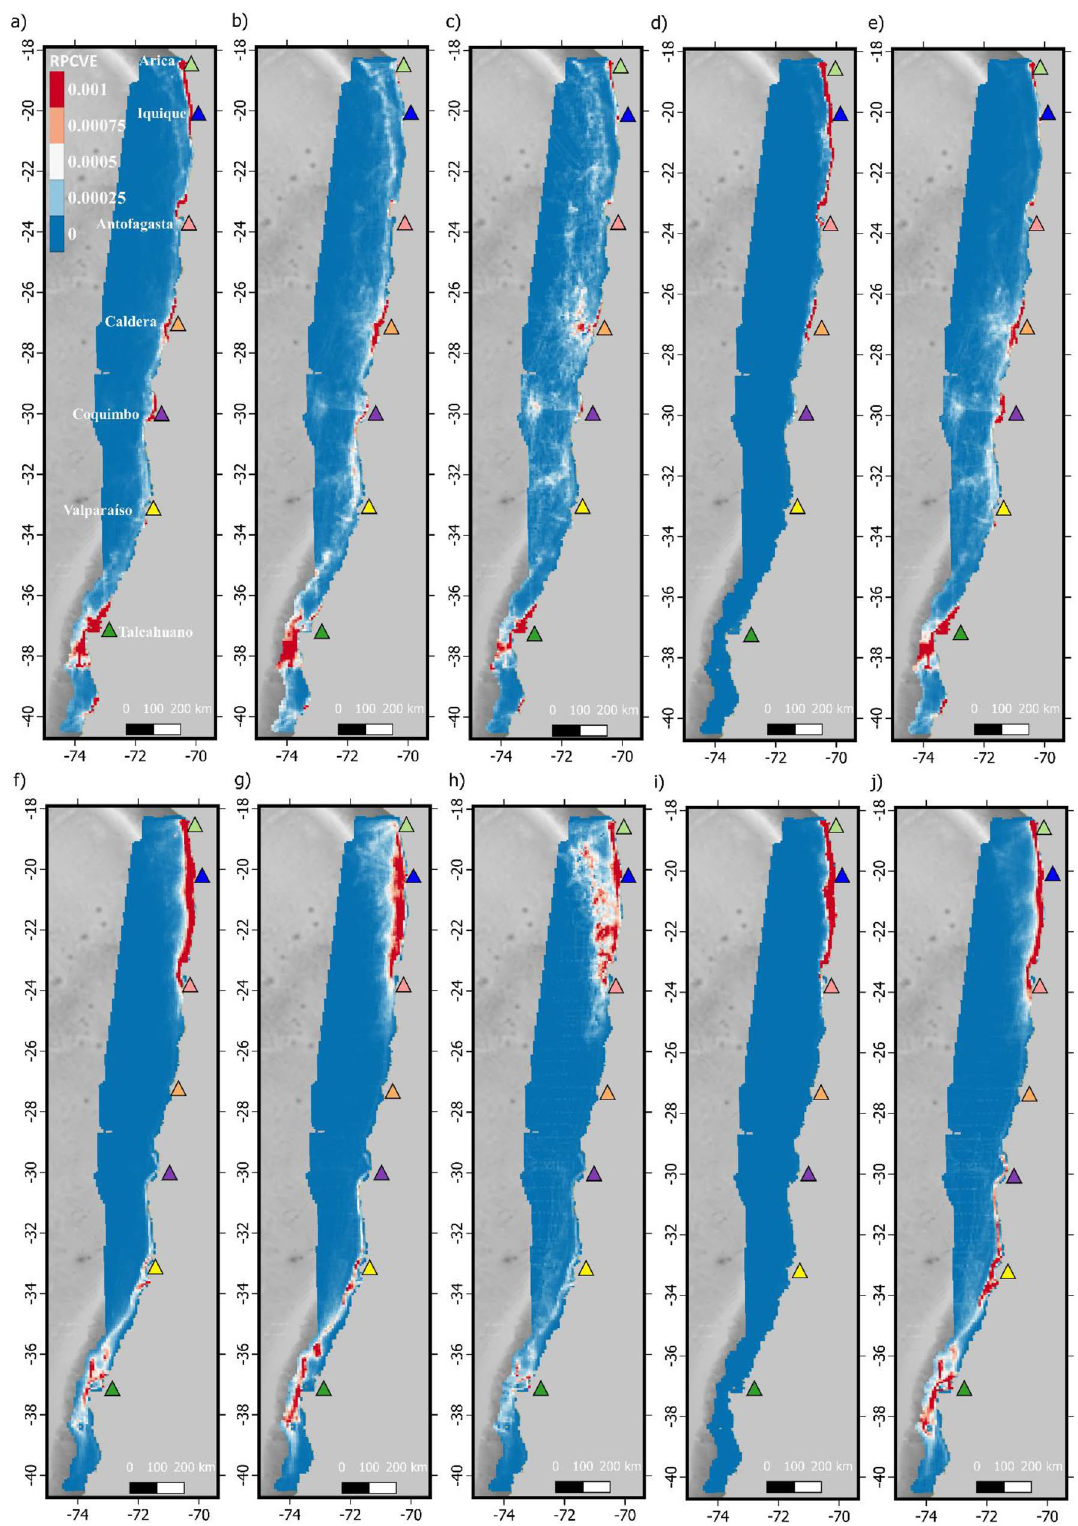
Figure 5. Predicted relative probability of cetacean-vessel encounter (RPCVE) for artisanal fishery fleet ( a – e ) and industrial fishery fleet ( f – j ). Columns show results for fin whales ( a , f ), blue whales ( b , g ), sperm whales ( c , h ), dusky dolphins ( d , i ) and common dolphins ( e , j ). Results for transport and aquaculture fleets are provided in Supplementary Fig. S18. Colored triangles indicate the location of most important ports. Data layers (including maps) were created in R ver. 4.0.2 (www.r- proje ct. org) and ensembled in QGIS ver. 3.8.0 (www. qgis. org) for final rendering. Maps were created using data on bedrock topography from the National Centers for Environmental Information (https:// maps. ngdc. noaa. gov/ viewe rs/ grid- extra ct/ index. html). Grid-cells with values above 0 were considered land coverage and assigned a uniform